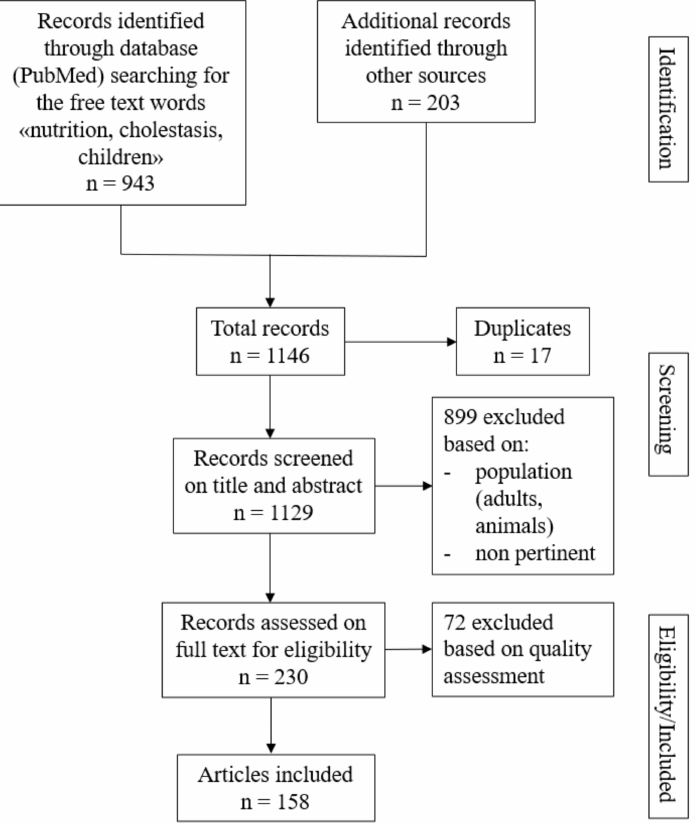
Figure 2. Flow chart showing the selection process to identify studies included in the article.